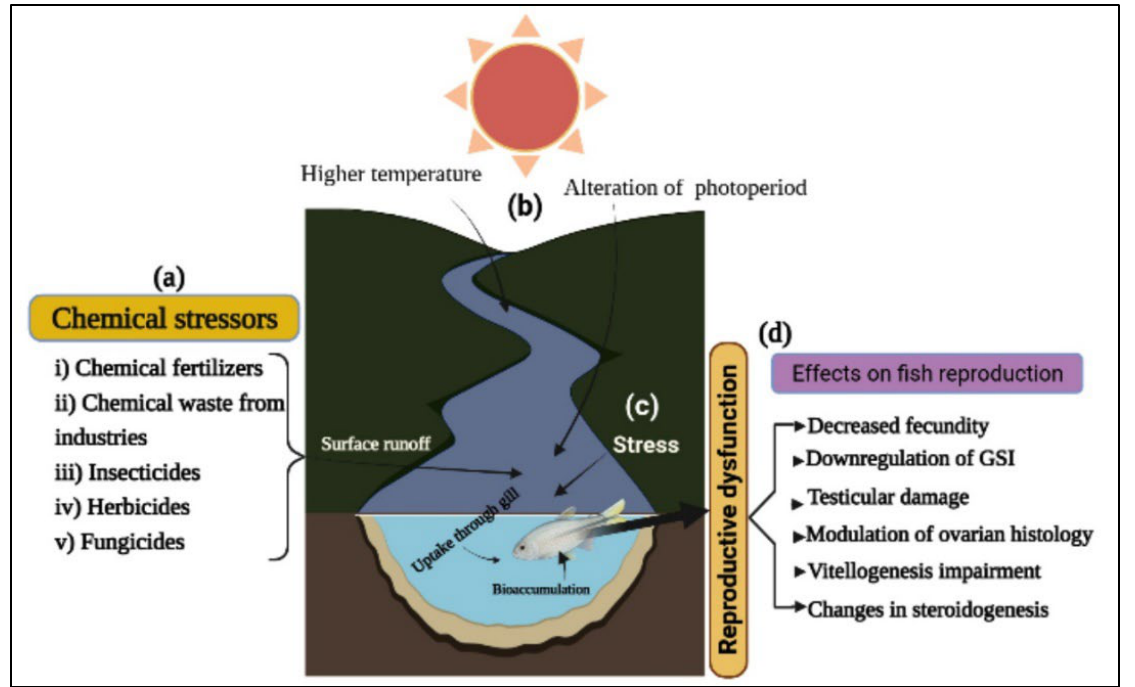
Figure 2. Presentation of different factors induced reproductive dysfunctions and effects in fish. ( a ) different chemical stressors mixed with the waterbody through surface runoff and uptake by gills resulted in bioaccumulation in the body; ( b , c ) alteration of temperature and photoperiod produce stress on the fish impact on physiology, immunology, and reproductive performance; ( d ) chemical and environmental stressors causing reproductive dysfunction in fish.